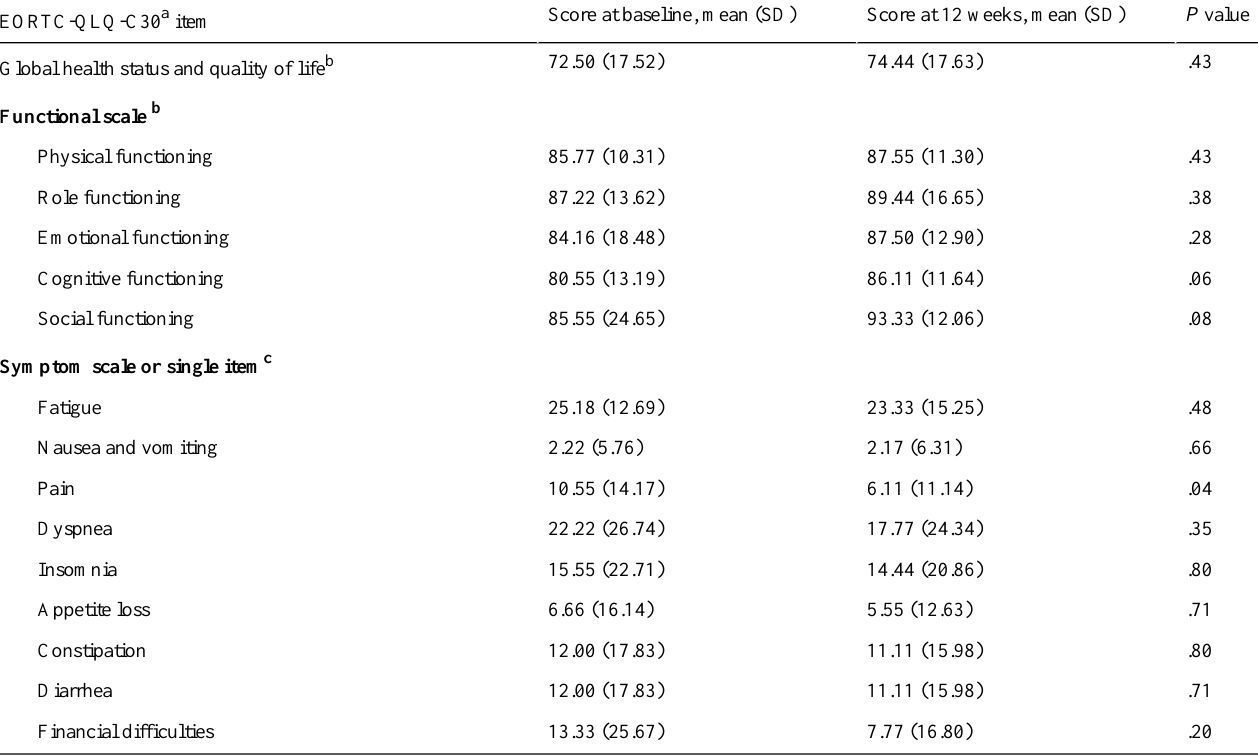
Table 4. Changes in quality of